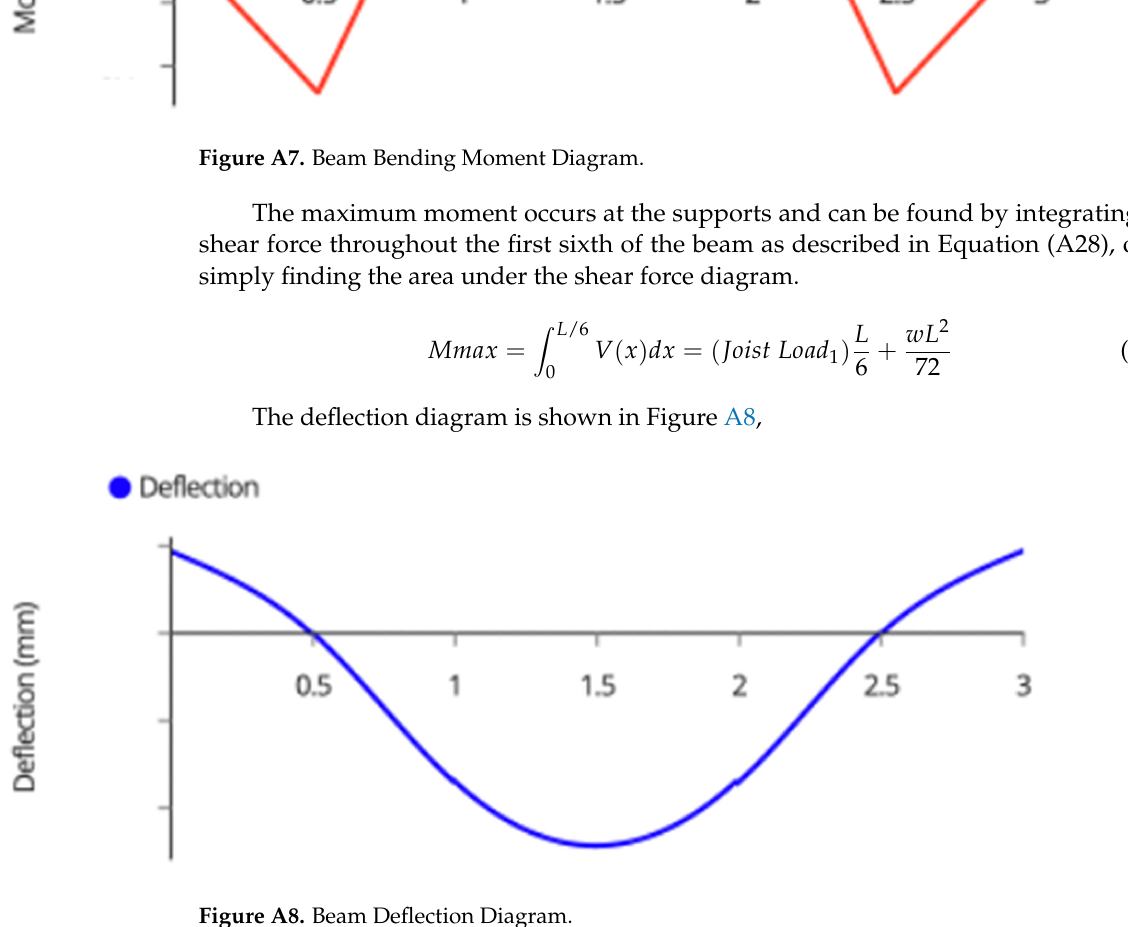
Figure A9. Post Free Body Diagram. The compressive load of the column is equal to the beam reaction solved above. Along with this compressive load comes a shear loading that is induced by wind and snow loads. This loading can act in either the left or right direction, but the load should be analyzed in the direction that induces bending in the same direction as the beam